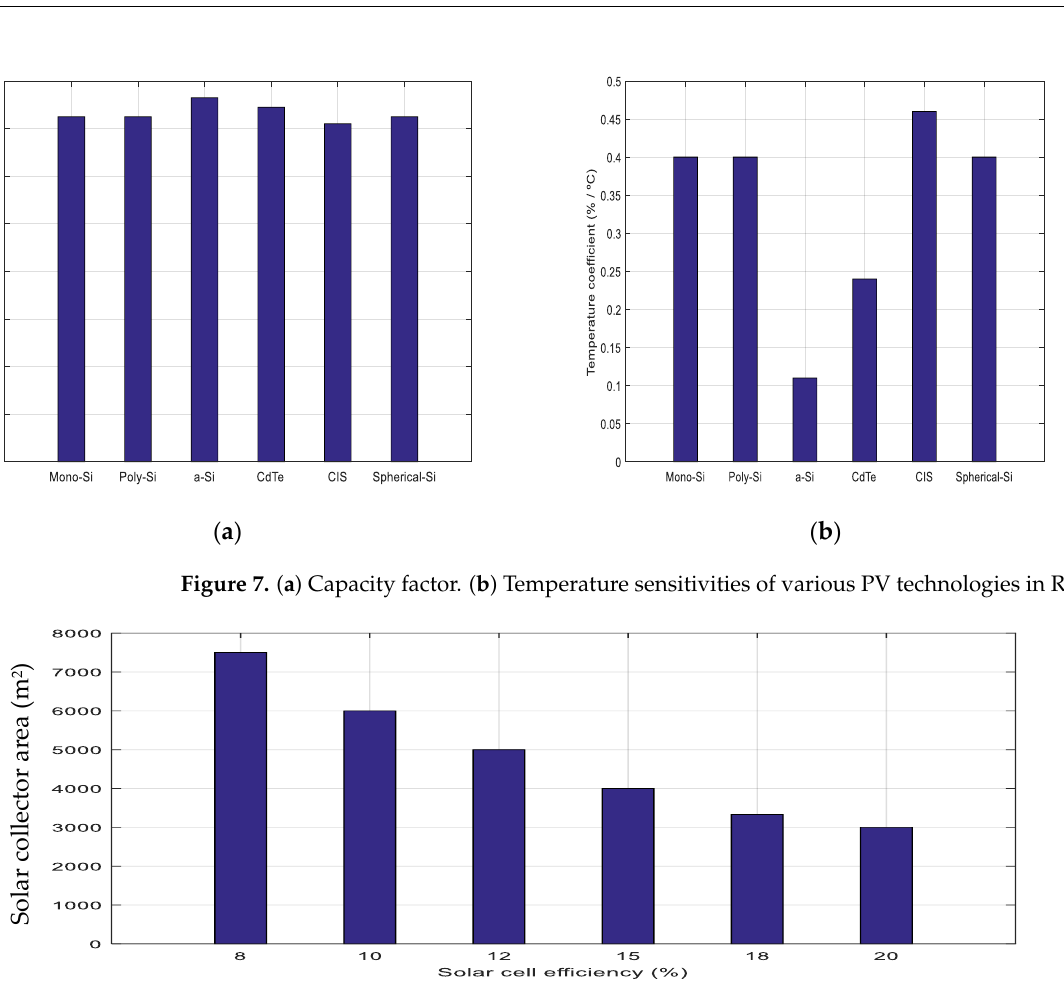
Figure 8. Impact of solar cell efficiency for a 600 kW solar project in RETScreen.